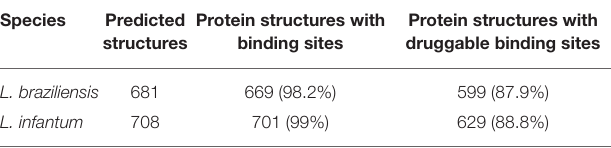
TABLE 1 | Total druggable binding sites.